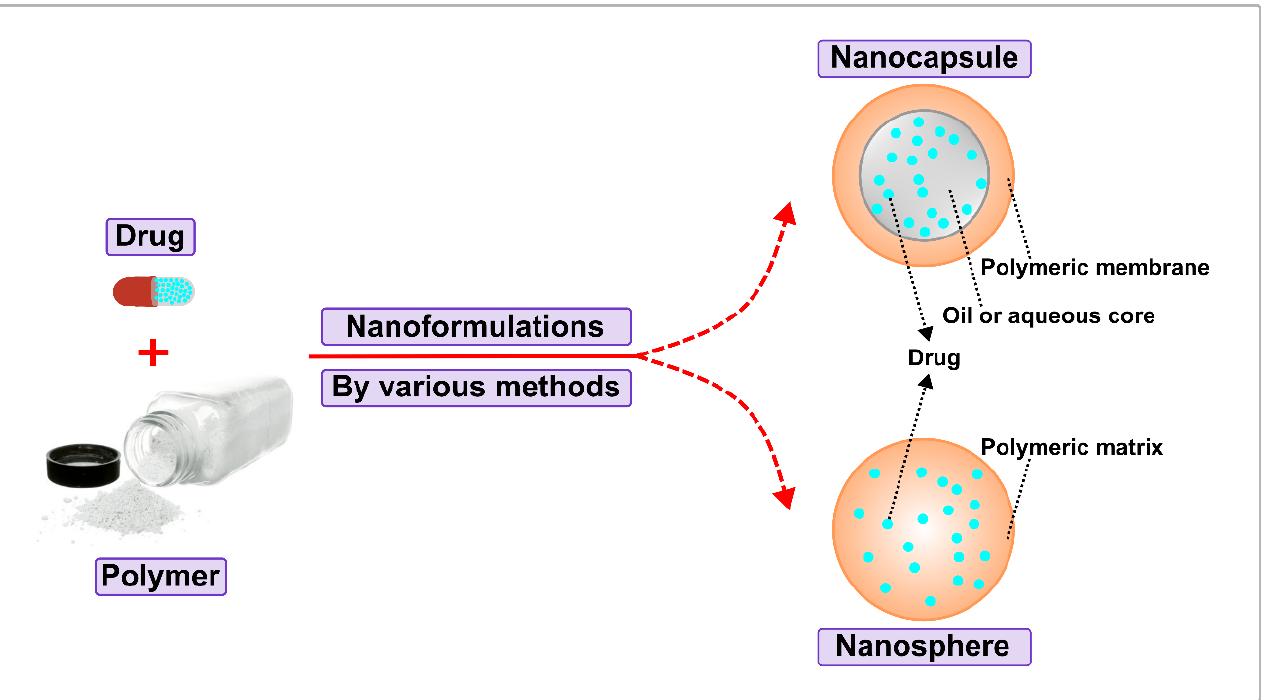
Figure 5. Classification of Biodegradable Polymeric Nanoparticles.